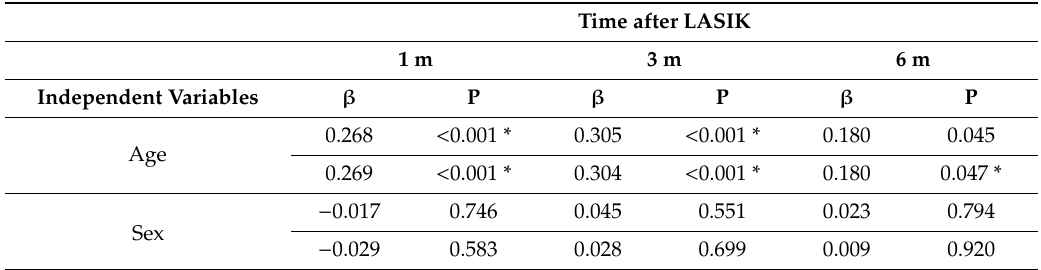
Table 3. The results of linear and multiple regression analyses on factors associated with satisfaction with the